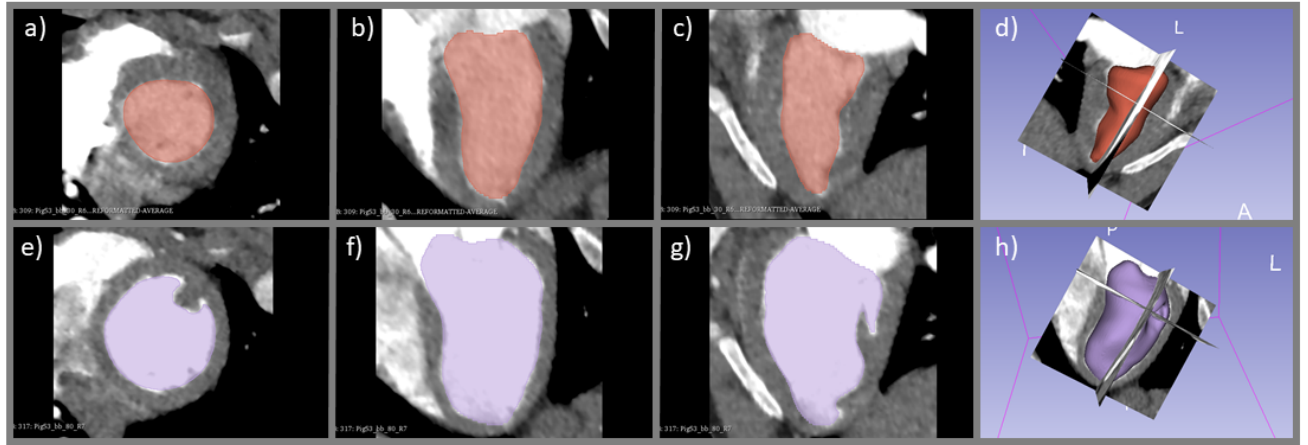
Figure 3. Segmentation of the left ventricular blood pool in the short axis ( a , e ), horizontal long axis ( b , f ), and vertical long axis ( c , g ) at the end-systolic (top row) and end-diastolic (bottom row) phases for assessment of the CO index with the ventricular delineation method. The relative position of the three orthogonal planes at the end-systolic and end-diastolic phases are illustrated in ( d , h ), respectively.